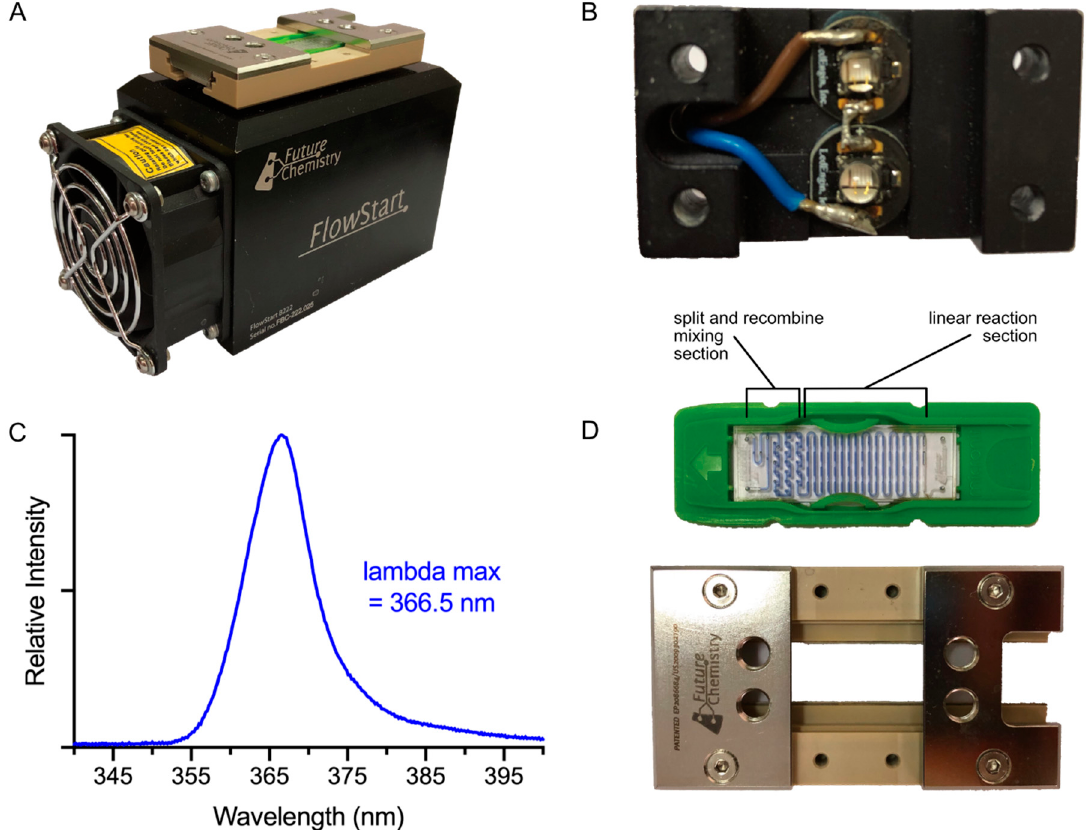
Figure 2. ( A ) FutureChemistry FlowStart B-222 photochemistry module. ( B ) LedEngin, Inc twin LEDs connected in series. ( C ) Emission spectra for the twin LED light source (combined plots). ( D ) Microfluidic chip (top), oriented in the direction of flow (left to right); and microfluidic chip holder with standard ¼ inch-28 screw-connectors for input and output.